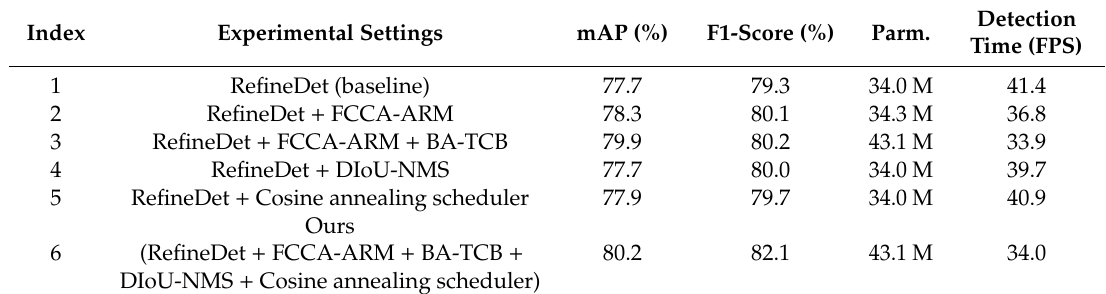
Table 4. Performance of components and optimization methods in our method.